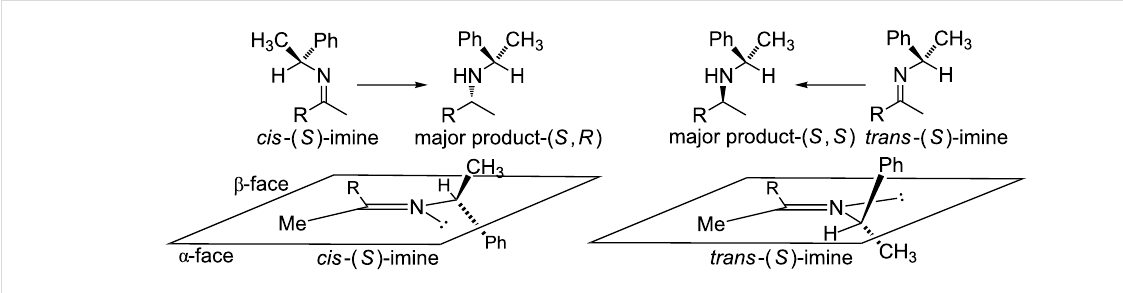
Figure 1: Accepted low energy conformations of the cis - and trans -imines of PEA.